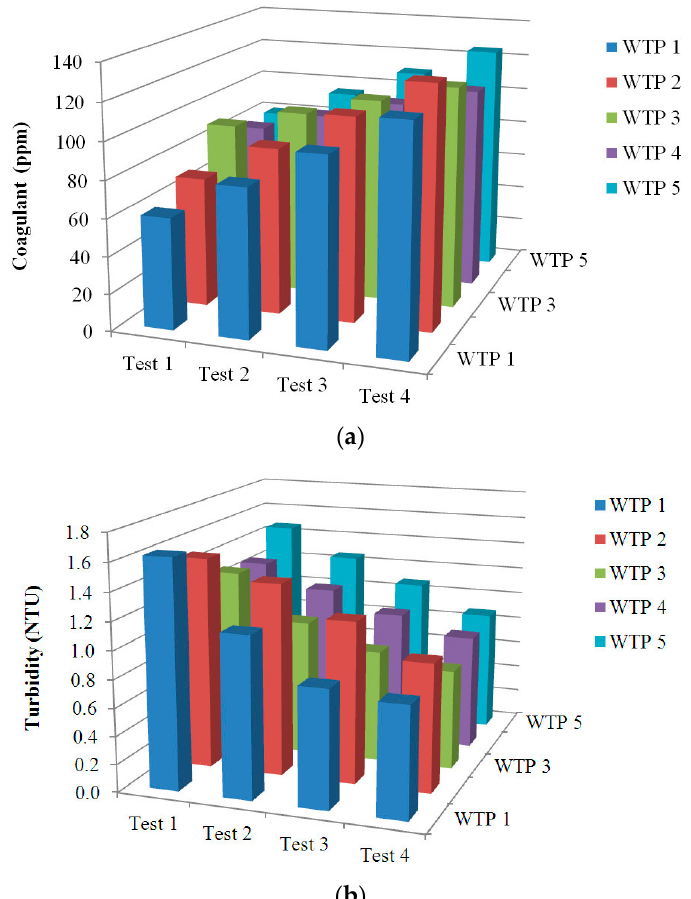
Figure 12. Three-dimensional graph of results of analyses performed: ( a ) Coagulant dosage; ( b ) Turbidity of filtered water. ( b ) Turbidity of filtered